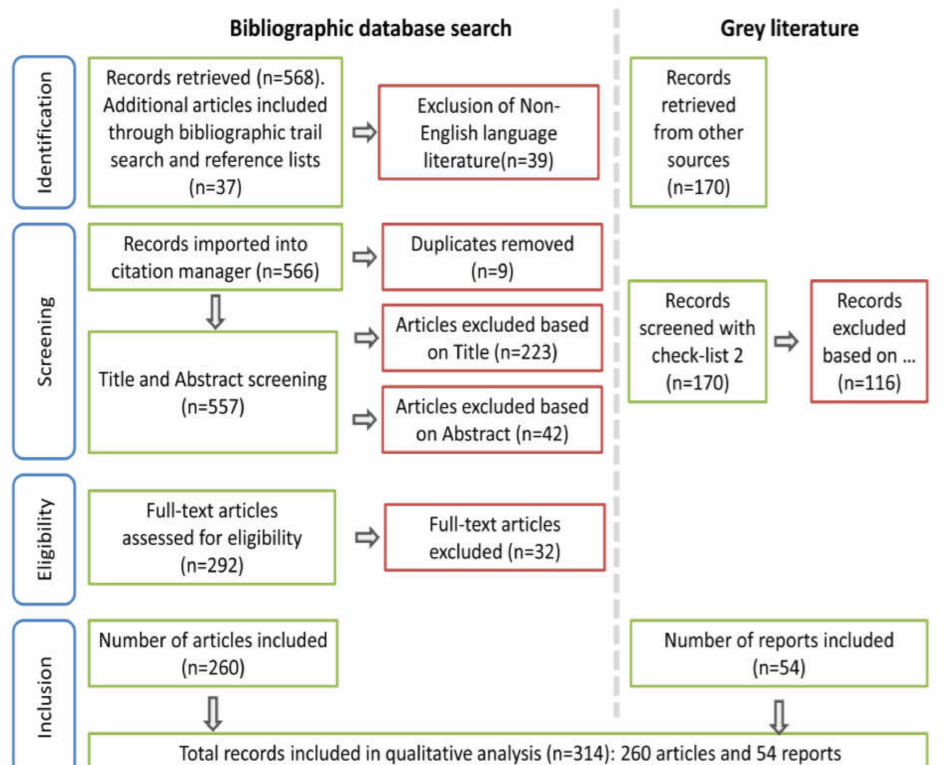
Figure 3. Flow chart of the strategy for locating the